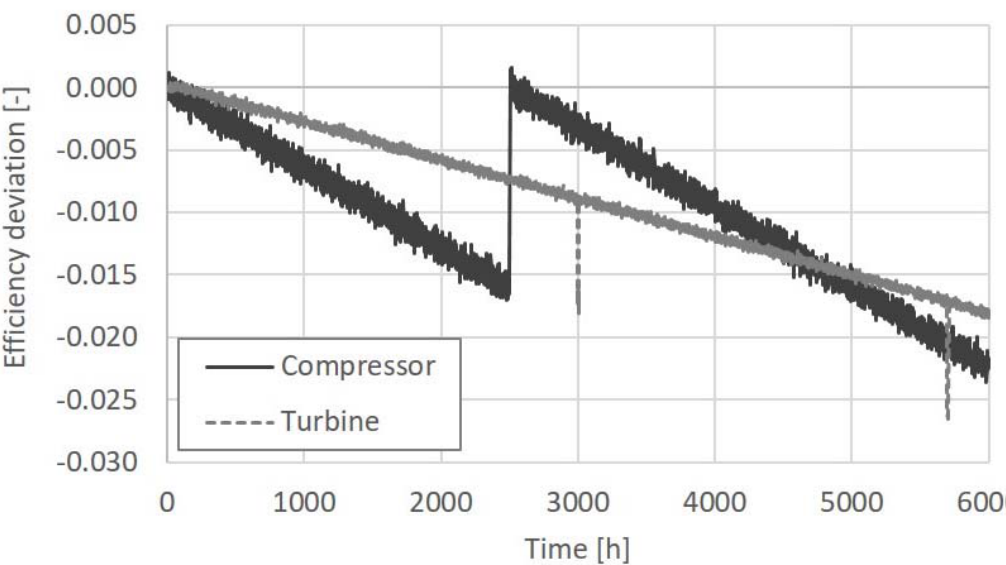
Figure 5. Estimated compressor and turbine efficiency deviations from the performance model in Scenario 1.